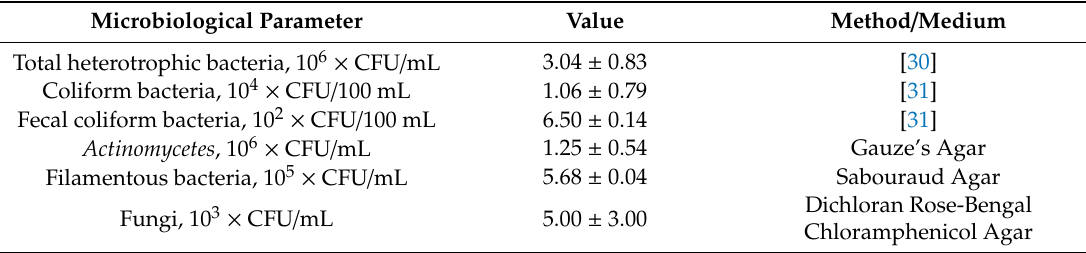
Table 3. Selected microbiological parameters of the KPL.